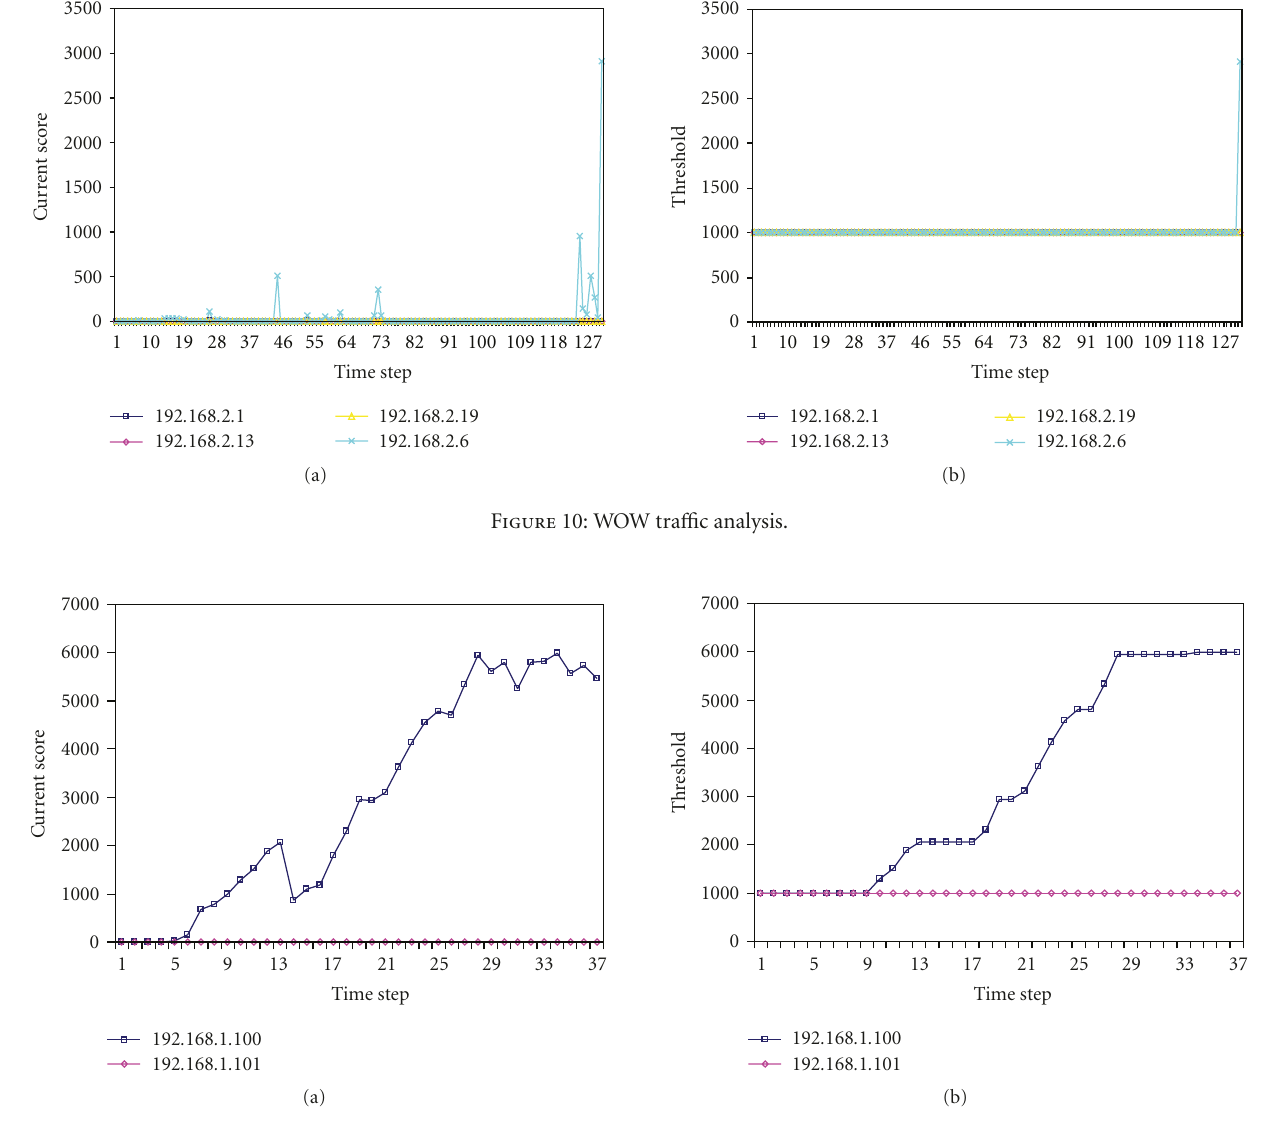
Figure 11: Emule tra ffi c